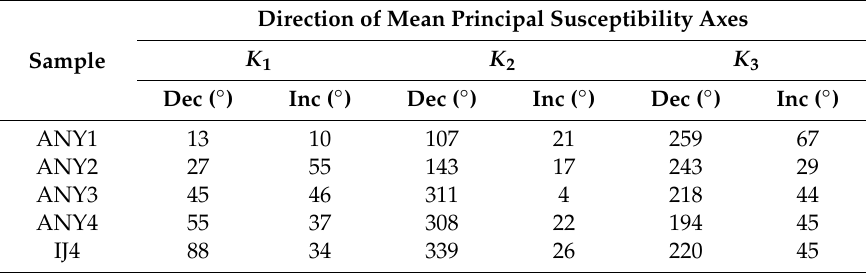
Table 3. Mean values of susceptibility axes of each sample.